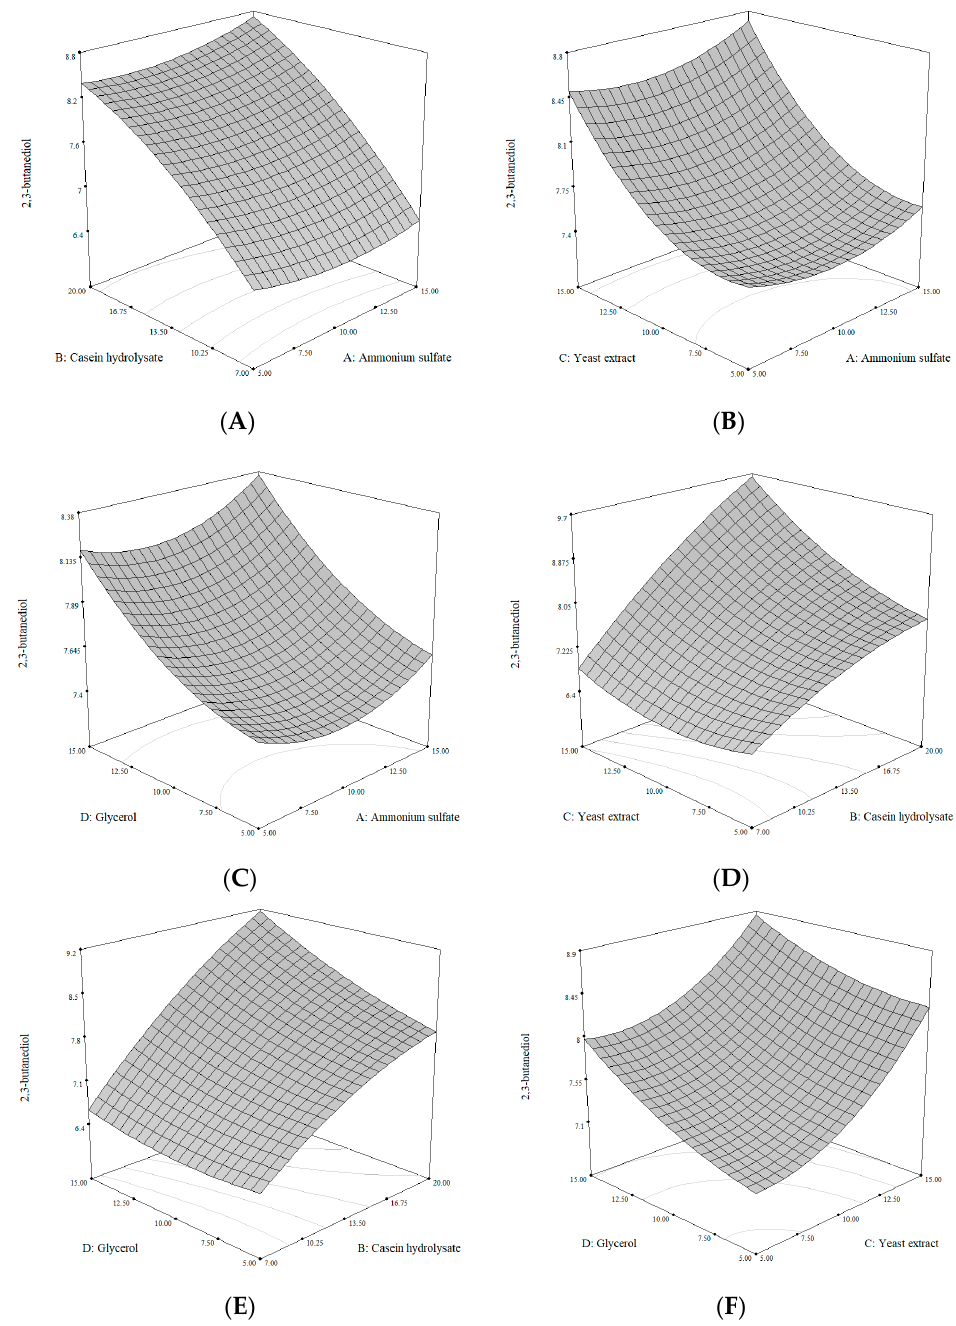
Figure 3. Response surface plots showing the interaction of each variable in 2,3-BDO production. ( A ) Effects of ammonium sulfate and casein hydrolysate, ( B ) effects of ammonium sulfate and yeast extract, ( C ) effects of ammonium sulfate and crude glycerol, ( D ) effects of casein hydrolysate and yeast extract, ( E ) effects of casein hydrolysate and crude glycerol, and ( F ) effects of yeast extract and crude glycerol on 2,3-BDO concentration.